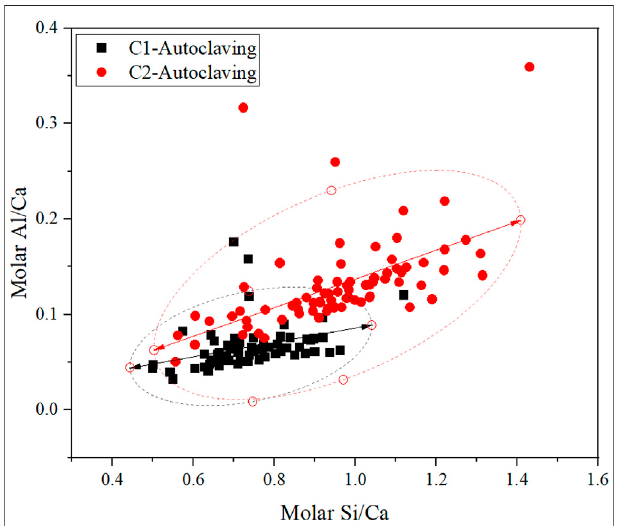
FIGURE 6 | Point element analysis of the hydrates in autoclaved samples ( fi tting result at 95% con fi dence level).